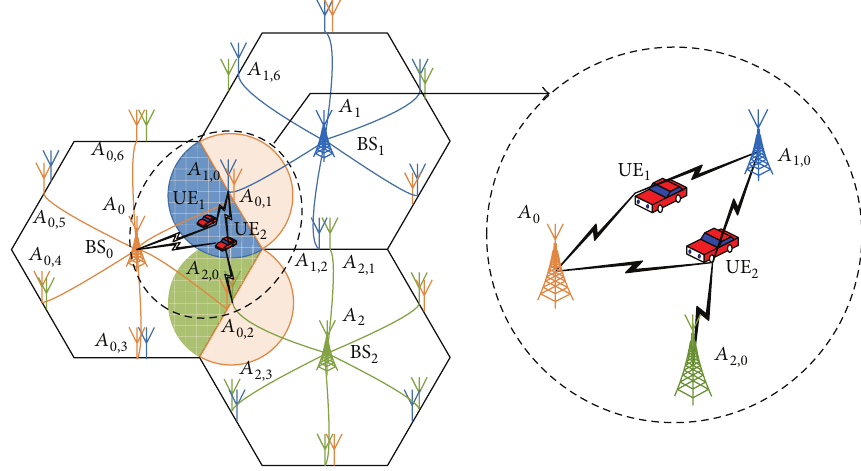
Figure 2: Examples of coordinated transmission for the